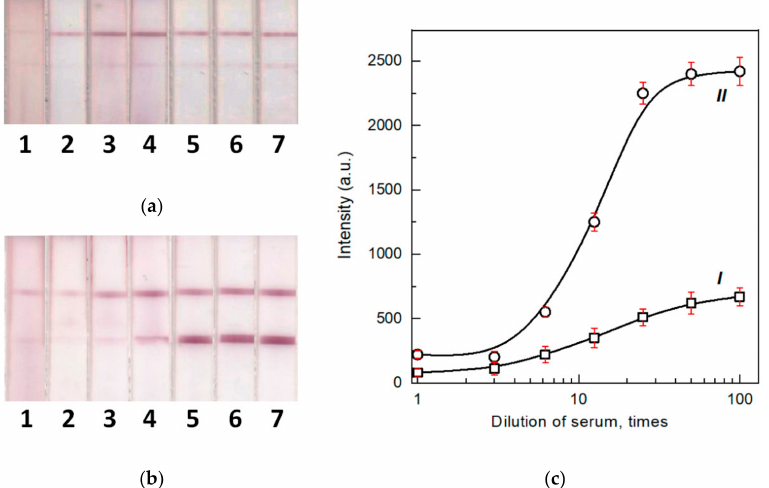
Figure 4. Images of test strips after the common ( a ) and enhanced ( b ) LFIA of samples containing 1- (1), 3- (2), 6.2- (3), 12.5- (4), 25- (5), 50- (6), and 100- (7) -fold dilutions of pooled negative human serum and 10 µ g/mL of monoclonal antibodies against RBD. ( c ) Concentration dependence of the common (I) and enhanced (II) LFIA ( n =